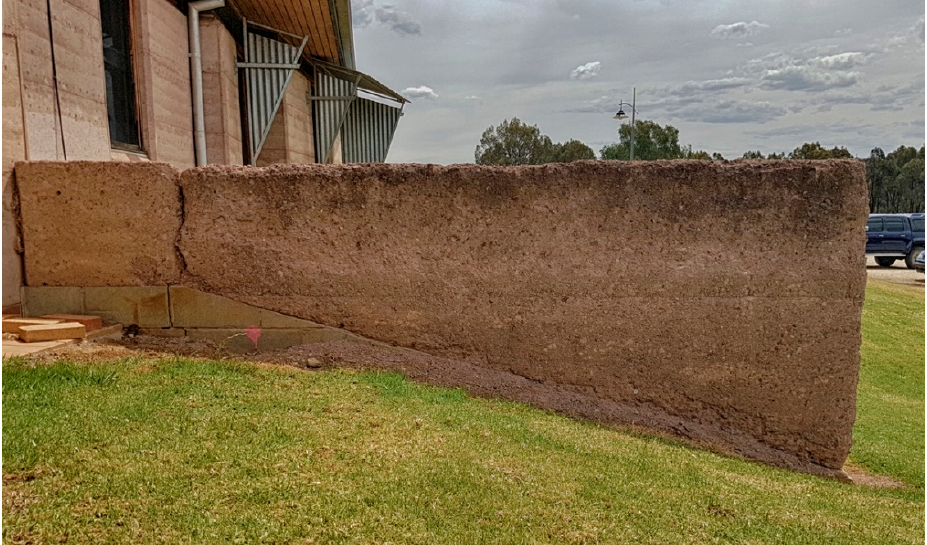
Figure 9. Wall 1 seen from the east.